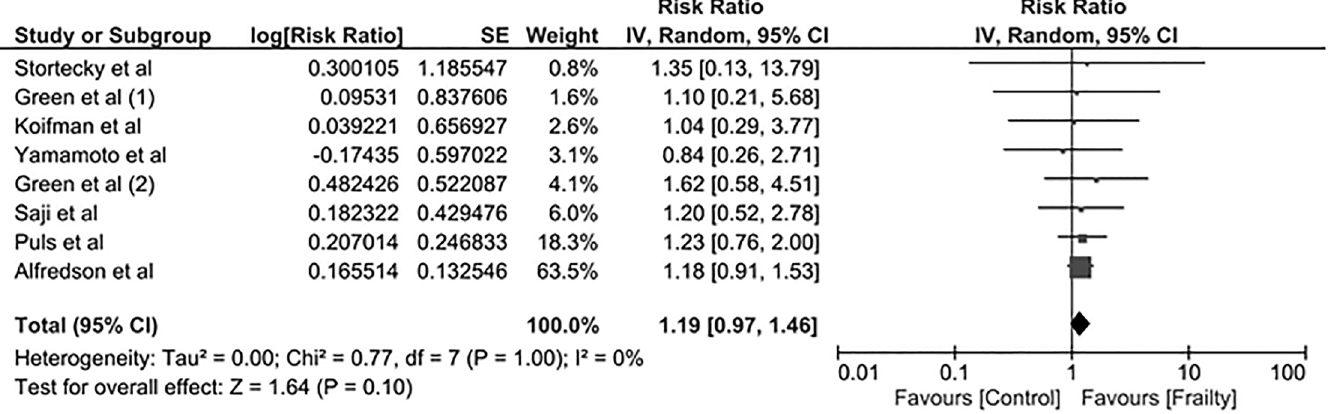
Fig 2. Forest plot of included studies comparing the risk of AKI after TAVR in frail vs. non-frail patients. Square data markers represent risk ratios (RRs), and horizontallines represent the 95% confidenceintervals (CIs) with marker size reflecting the statistical weight of the study using random-effects model. A diamonddata marker represents the overall RR and 95% CI for the outcome of interest.